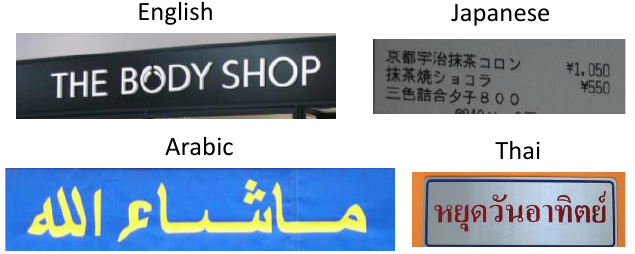
Figure 1. Examples of different character structures and text line structures from various